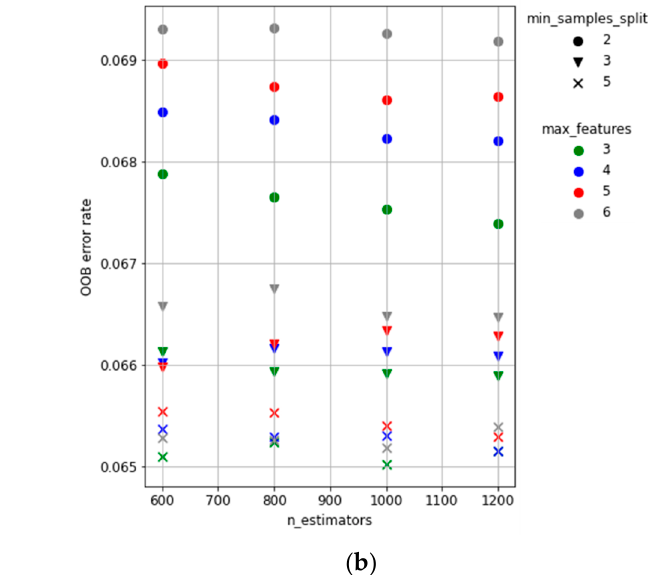
Figure 4. Results of calibration process. OOB overall error rate as a function of n_estimators , min_sam-